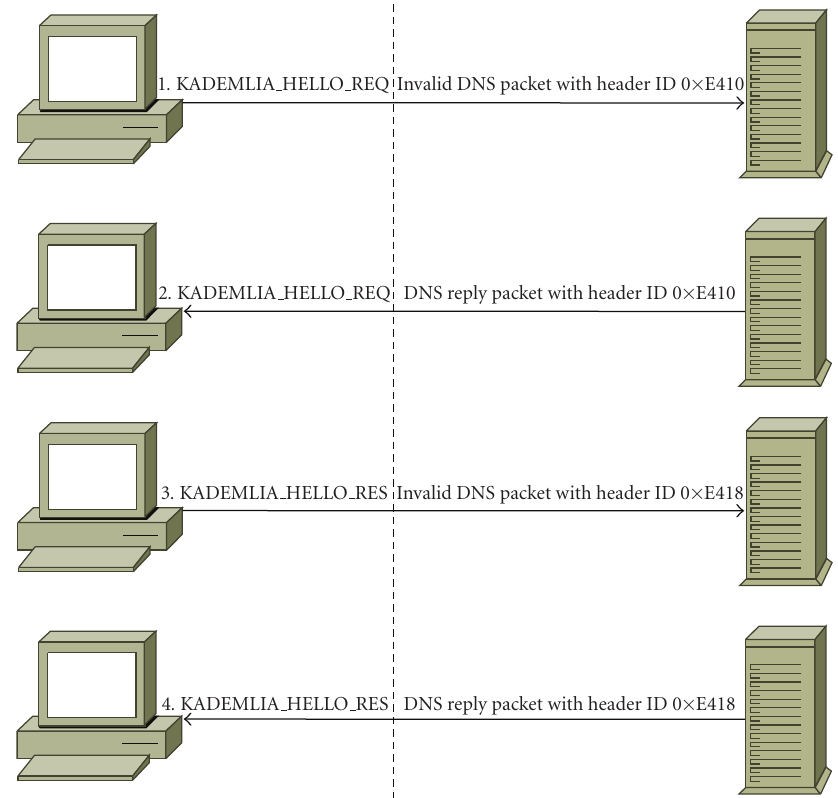
Figure 7: The eMule client is misguided when getting echo from dns